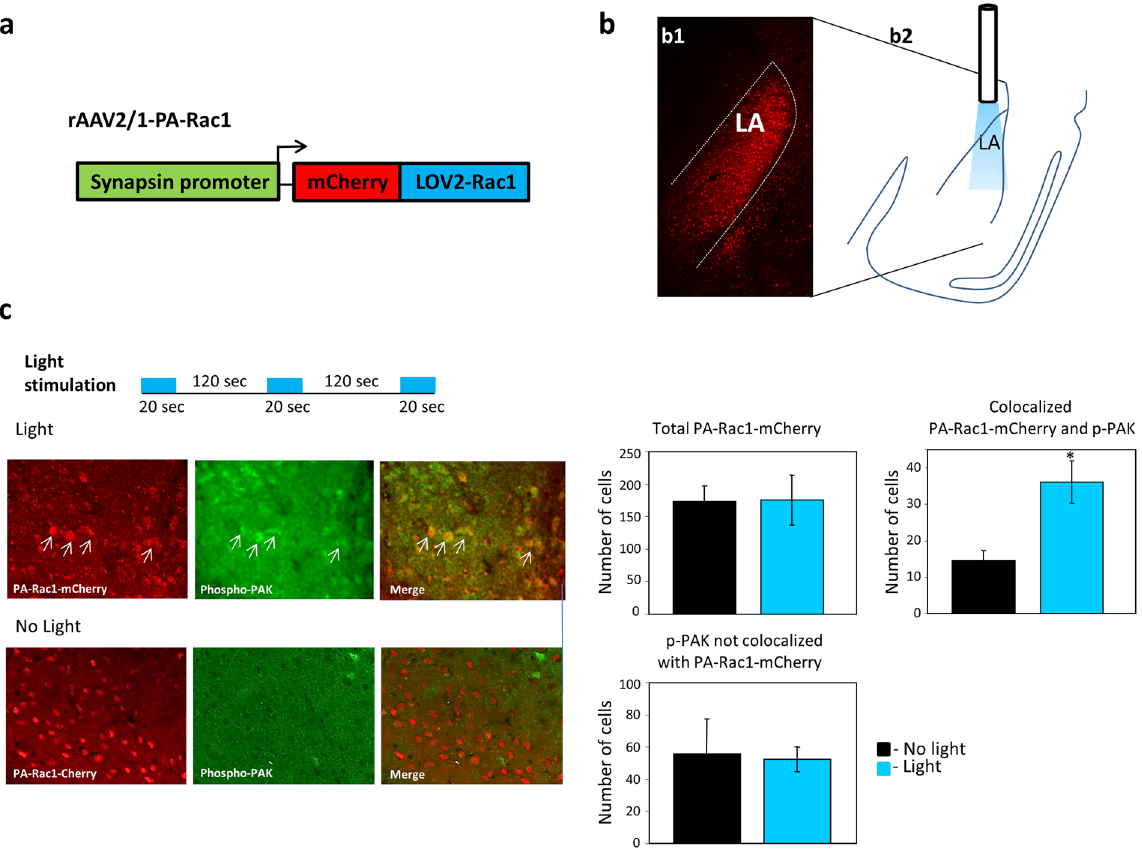
Figure 1. Activation of Rac1 GTPase in LA leads to increase in PAK phosphorylation. (a) Schematic description of the vector expressing Rac1 conjugated to LOV2 (PA-Rac1) and mCherry under the control of synapsin1 promoter. (b) PA-Rac1 is expressed in lateral amygdala (LA) as depicted by expression of mCherry (b1). The area of illumination by optic fiber includes the LA (b2). (c) Phospho-PAK is measured in the amygdala in light stimulated animals 30 minutes after stimulation (same light stimulating protocol used in behavior) and in animals that were not subjected to light. Left panels are representative immunohistochemistry of phospho- PAK and PA-Rac1-mCherry expression in AAV injected animals in light and no light animals. Arrows point at examples of phospho-PAK in PA-Rac1 expressing cells. Right graphs are quantifications of labeled cells (n = 6 mice no light, n = 7 light). The mean of total number of cells from slices from all animals in each group is shown. More phospho-PAK is detected in cells expressing PA-Rac (mCherry) in light exposed animals compared with animals that were not subjected to light (p <